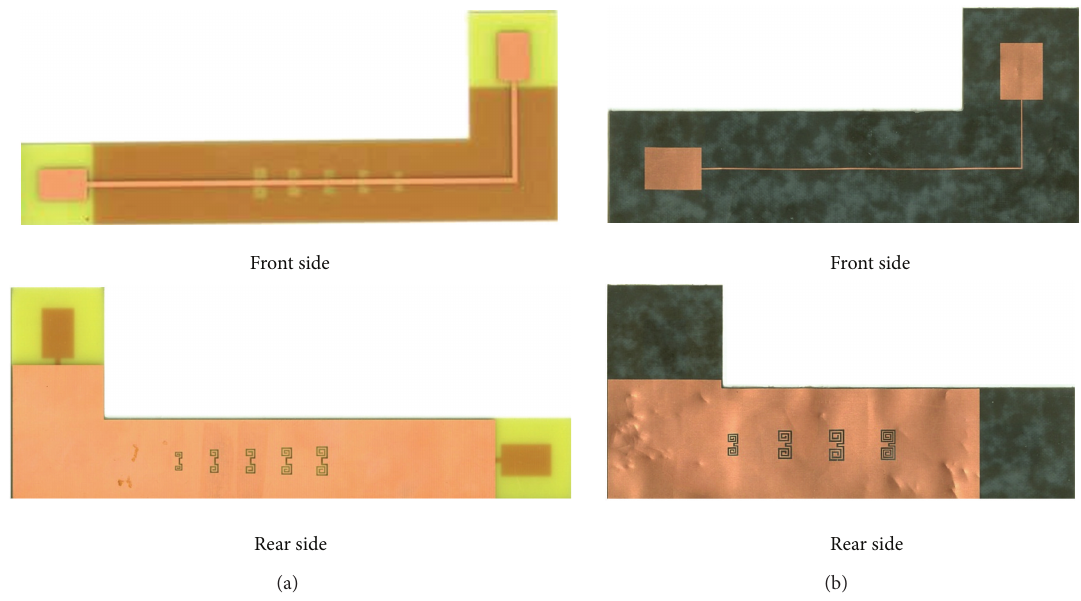
Figure 10: Photographs of implemented microwave tag systems: (a) on the thick substrate, (b) on the flexible thin